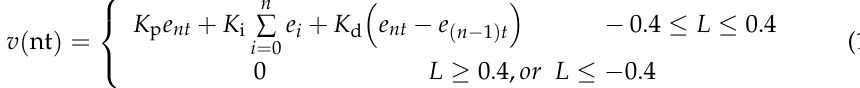
Figure 5. A schematic diagram of depth control. The control system works as described above. In this paper, the position L of the shifting weight was described in the coordinate system O 2 - X 2 Y 2 Z 2 whose O 2 is the center of gravity of the towed vehicle not including the shifting weight. The PID-based control system controls the speed of the shifting weight to control the longitudinal position of the shifting weight [21]. In the control system, to avoid the damage caused by the collision between the shifting weight and other structures, limit positions of the shifting weight are defined. When the shifting weight oversteps the safety range, the longitudinal velocity of the shifting weight becomes zero until the system output makes the shifting weight return to the safety range. The longitudinal velocity v (nt) of the shifting weight can be written as: